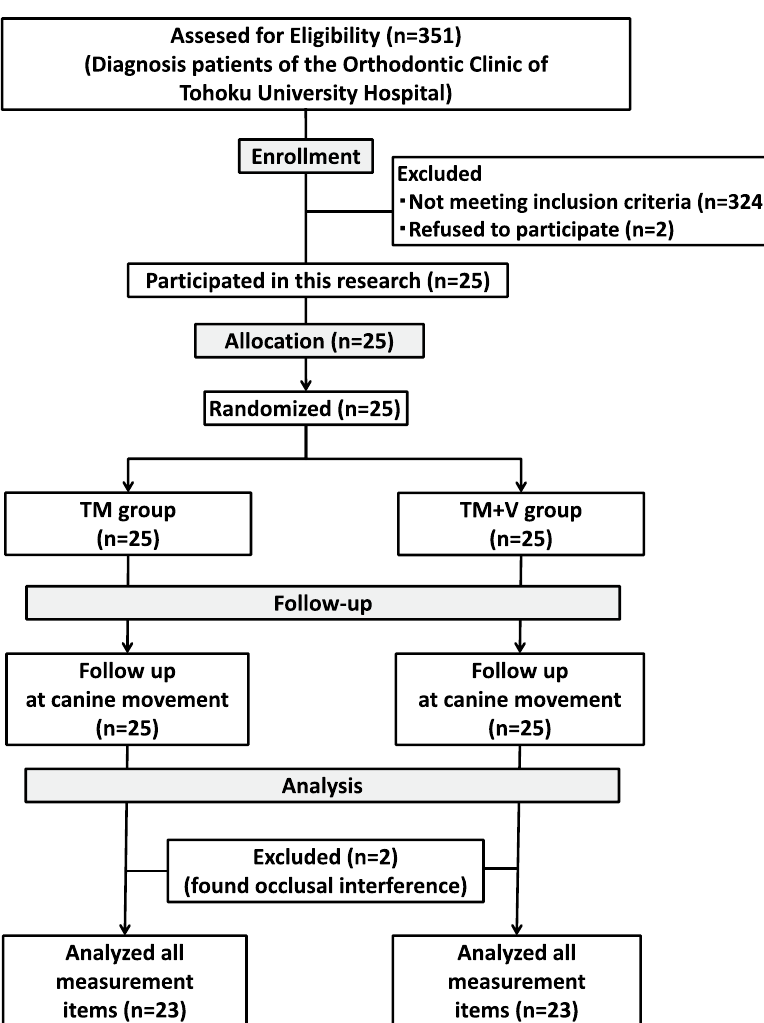
Figure 1. CONSORT diagram. Twenty-seven subjects provided consent explanations, two of whom refused to participate. The left and right side dentition of the twenty-five subjects were randomly classified into the TM group and the TM + V group. Two of the twenty-five subjects had occlusal interference and were excluded from the